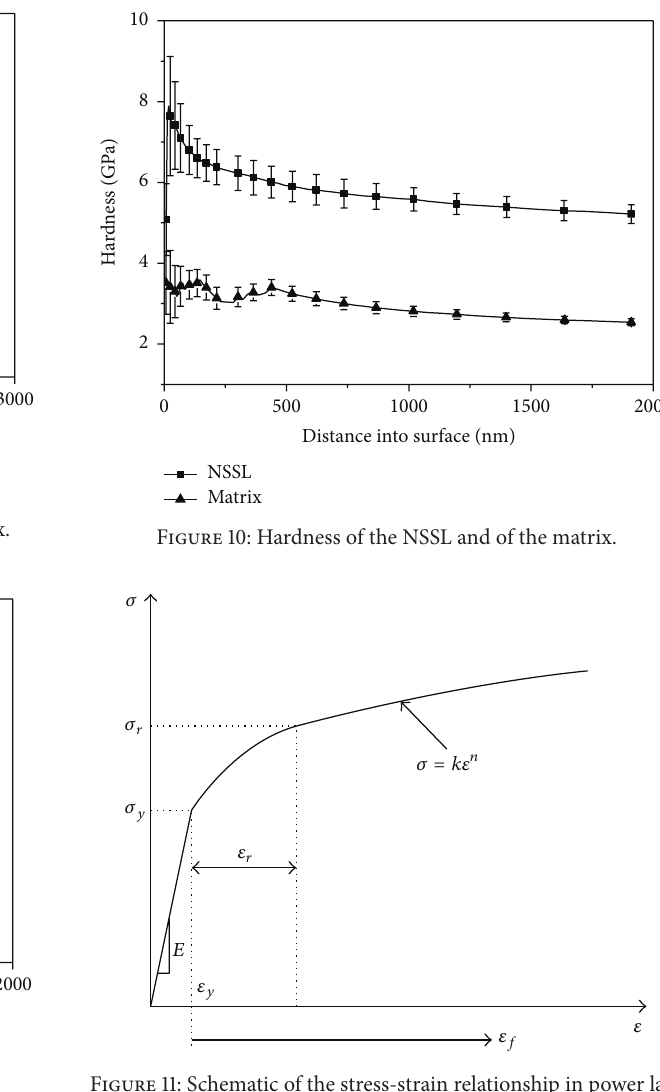
Figure 11: Schematic of the stress-strain relationship in power law. [25] determined that the representation of the inverse of the ratios 𝐸 𝑟 /𝐻 exhibits linear behavior as a function of 𝐸 𝑟 /𝜎 𝑟